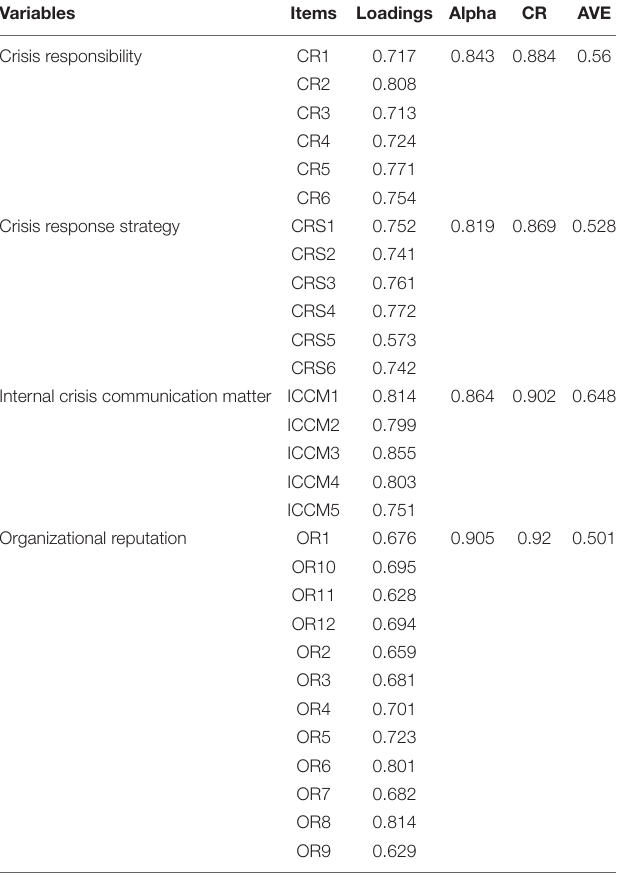
TABLE 2 | Factor loadings, composite reliability (CR), and convergent validity.